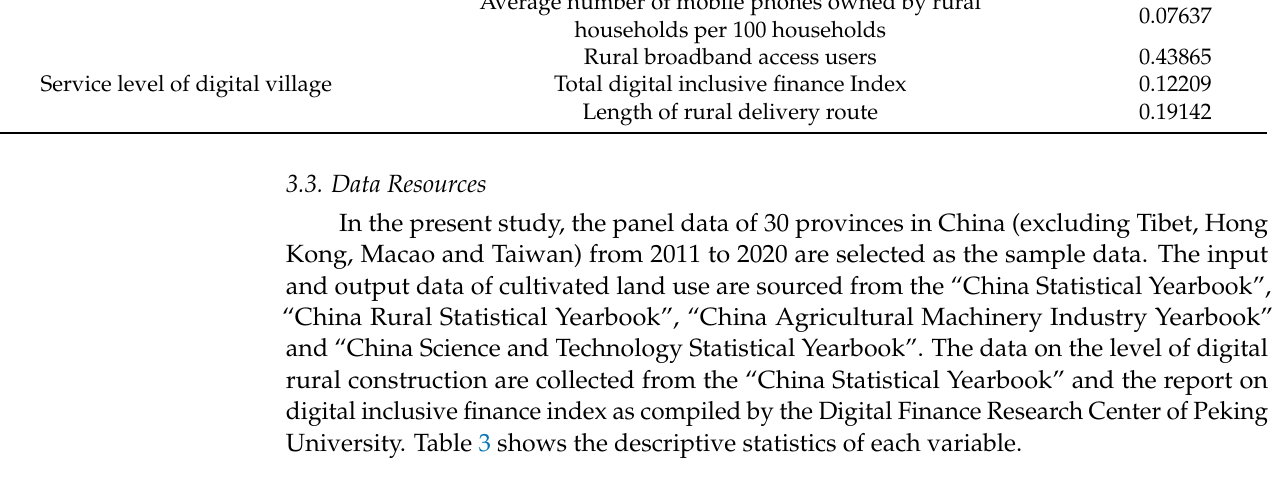
Table 3. Descriptive